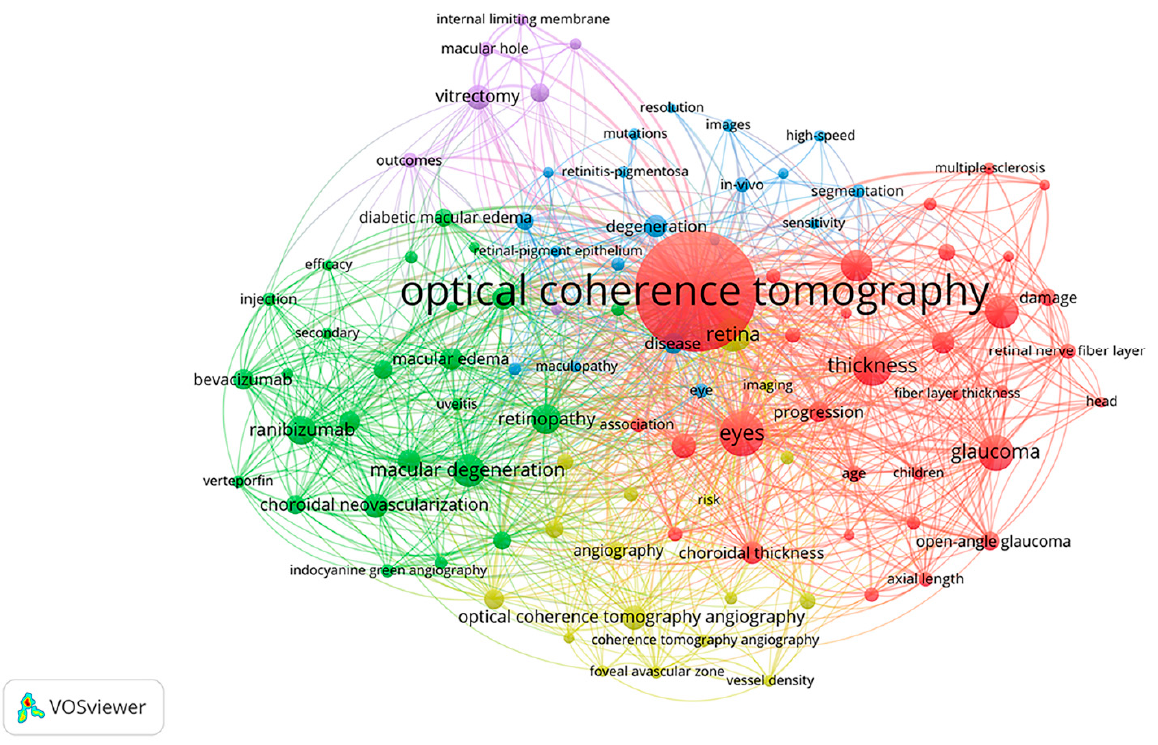
Figure 2. Co-occurrence analysis of the top 100 keywords.